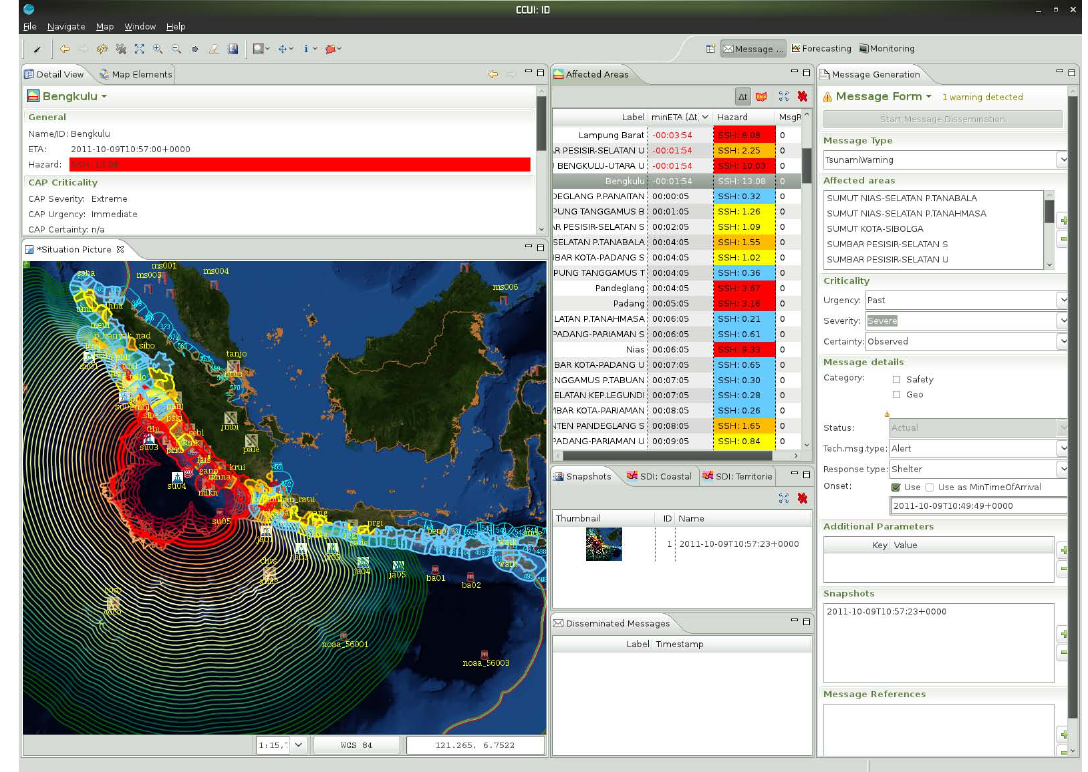
Fig. 9. Message Composition